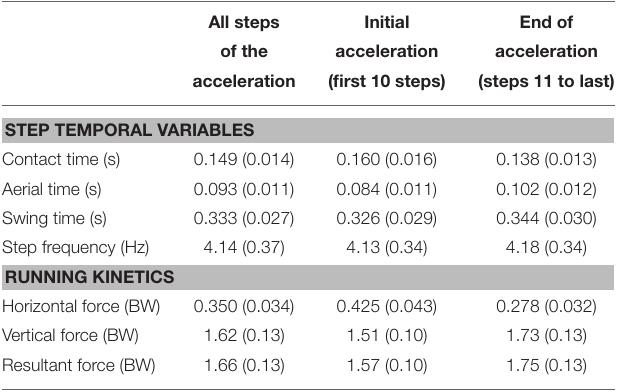
Frontiers in Physiology |